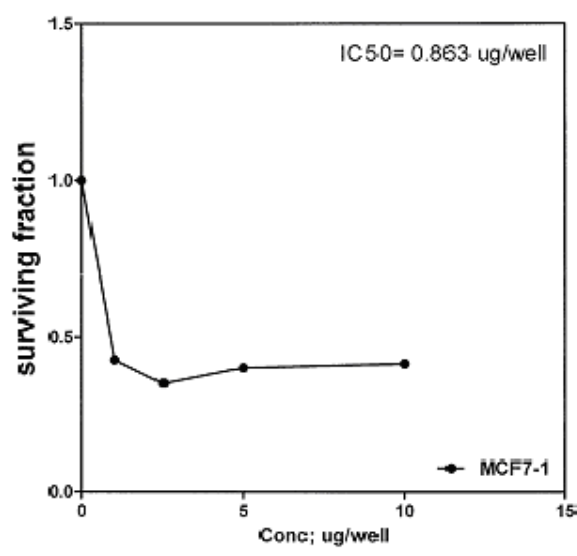
Figure 3. Effect of conc. of 2b on MCF-7